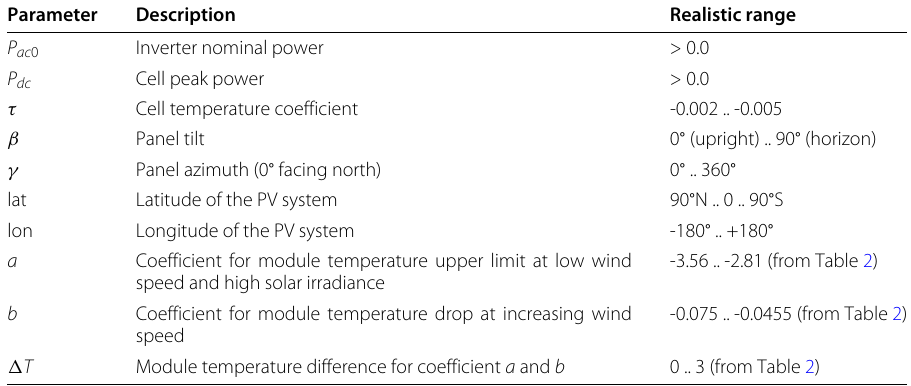
Table 3 List of model parameters